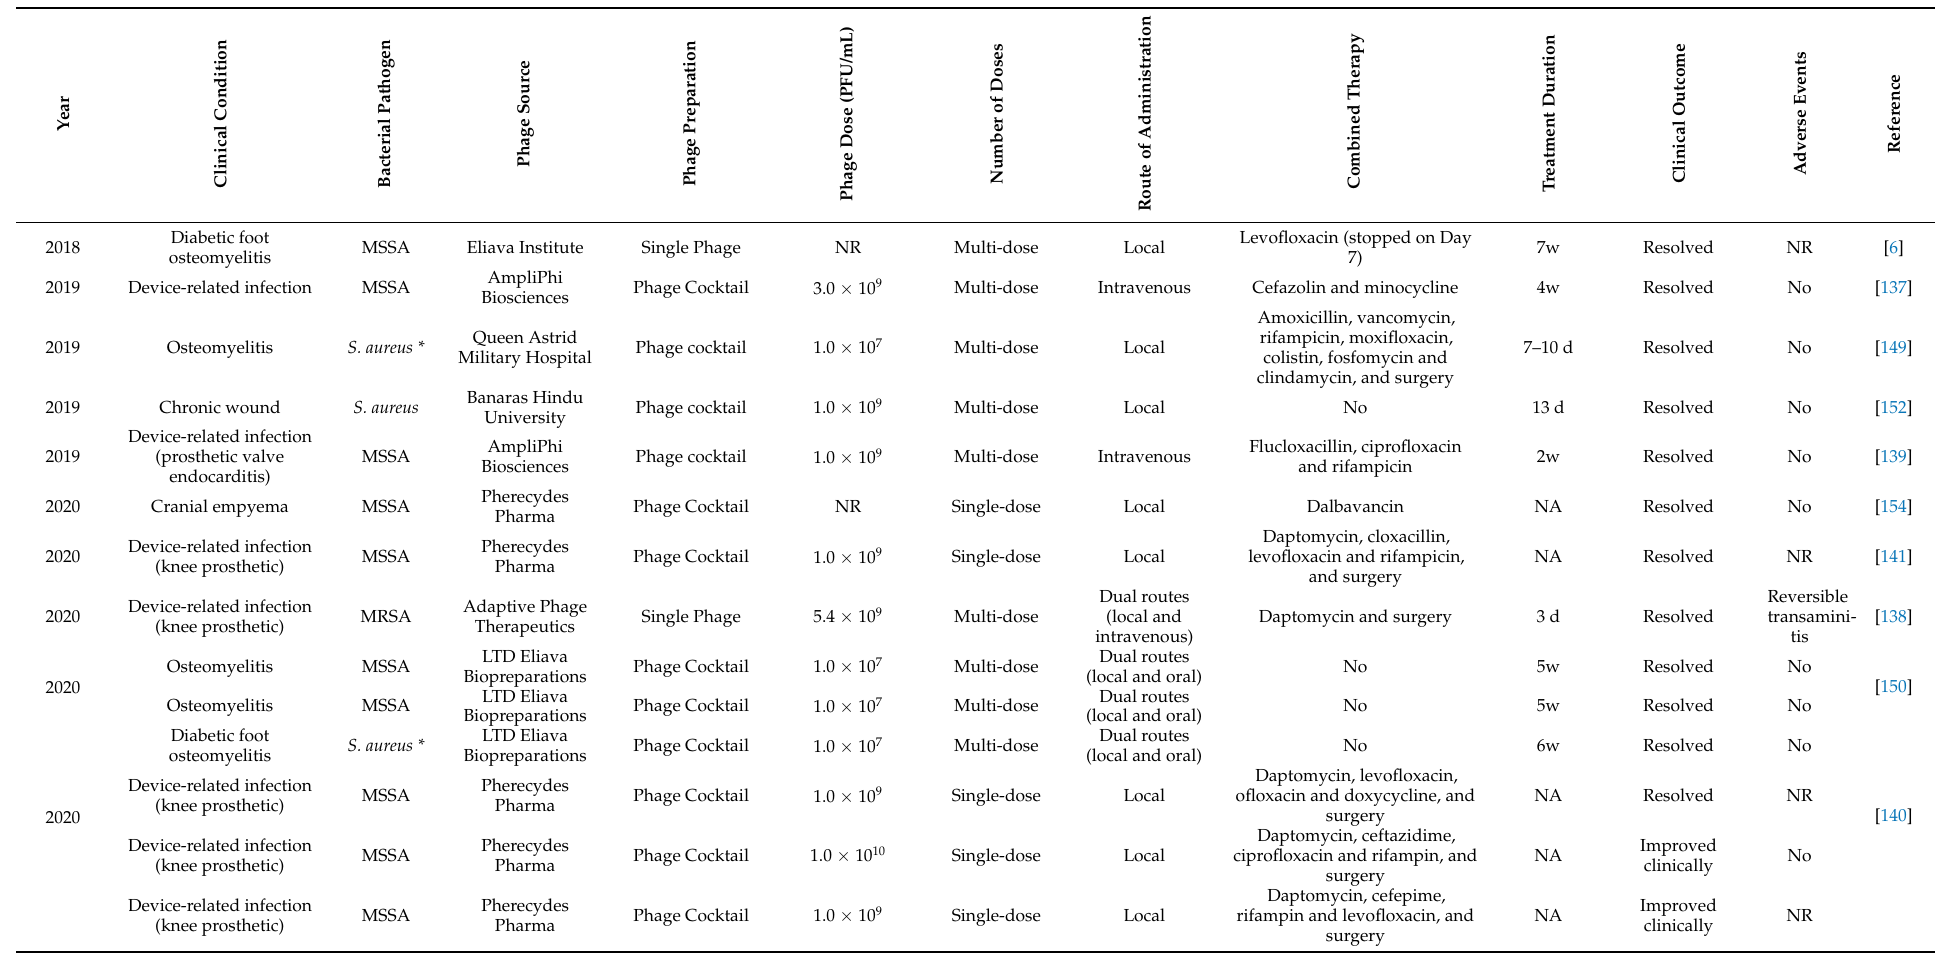
Table 1. Overview of the application of phage and phage-related therapy against Staphylococcus aureus biofilm-related infections in humans between 2018 and